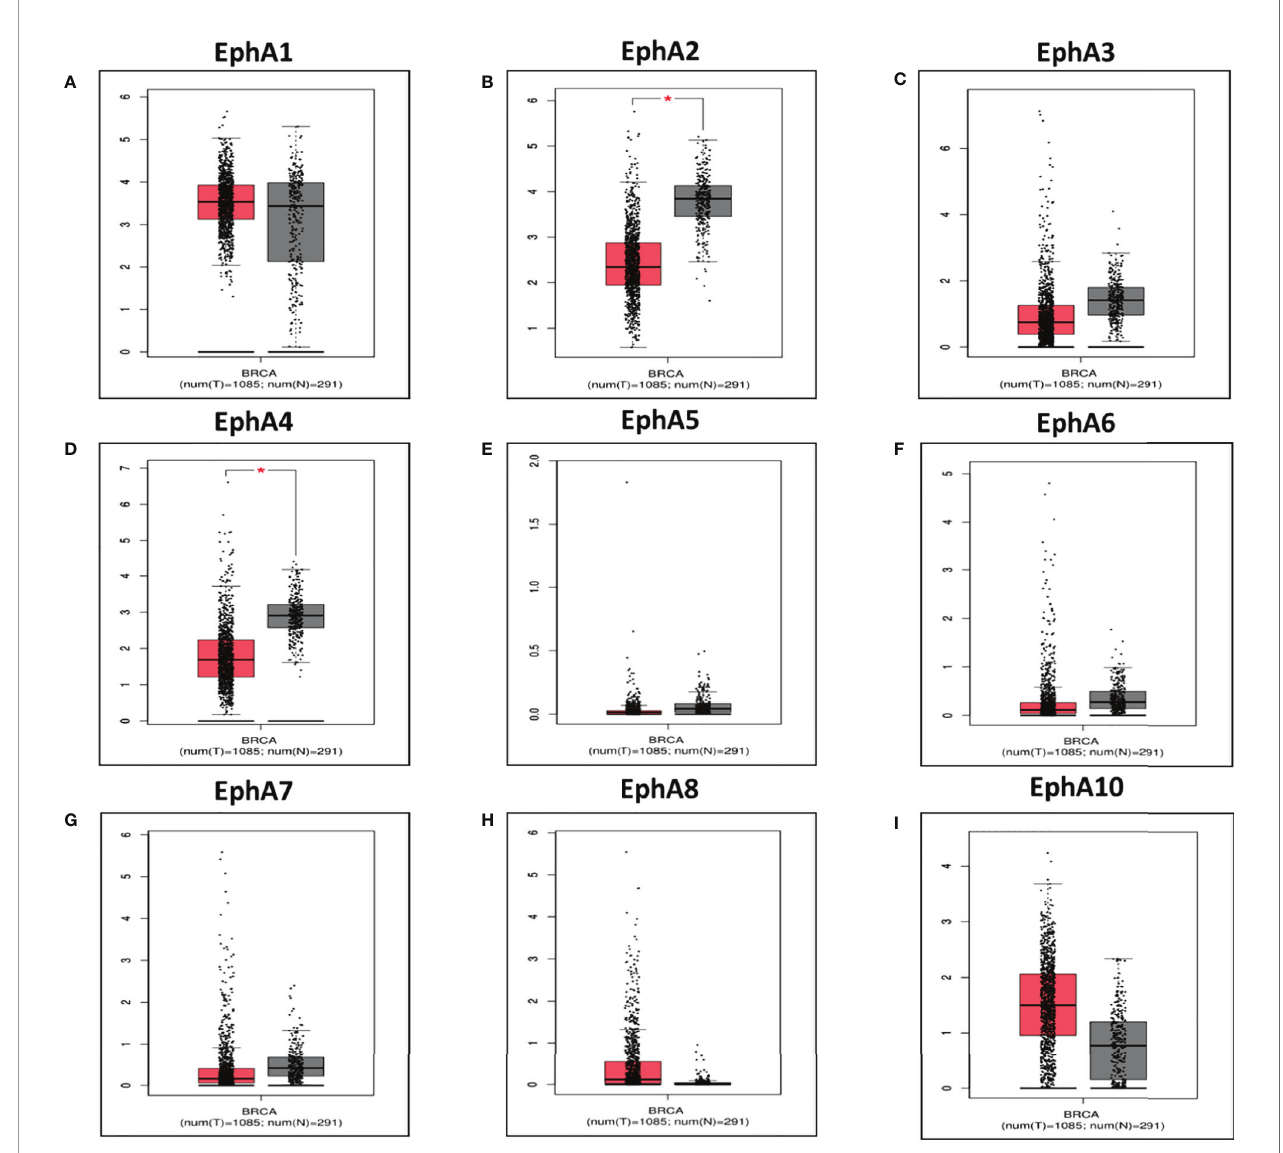
FIGURE 2 | The expression of EphA family in breast cancer vs in normal. The graphs generated from GEPIA database showed the EphA family gene expression in breast cancer tissues (BRCA) (n = 1085) compared with normal breast tissues (n = 291), *P < 0.05. The tumor tissues were shown in red and the normal tissues were shown in gray. The EphA family genes include (A) EphA1; (B) EphA2; (C) EphA3; (D) EphA4; (E) EphA5; (F) EphA6; (G) EphA7; (H) EphA8; (I)